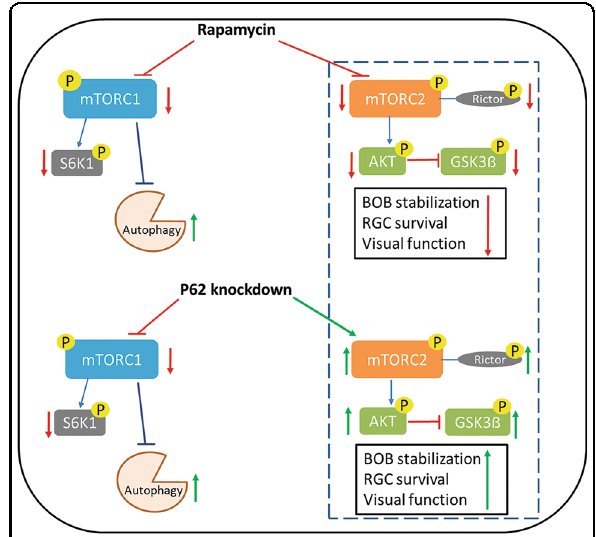
Fig. 6 Summary of the role of autophagy inducer in the ONC model. Two autophagy inducers showed a dramatic difference in neuroprotective effects in the ONC model. Treatment with p62 siRNA results in a favorable neuroprotective effect by triggering speci fi c mTORC1 deactivation and maintaining mTORC2 activation, which leads to the reduction in neuroin fl ammation through BOB protection and M2 macrophage polarization. Rapamycin can activate autophagy but provides no protection in the ONC model because the inactivation of mTORC2 results in BOB disruption, which may induce macrophage in fi ltration and pro-in fl ammatory cytokine-induced optic nerve